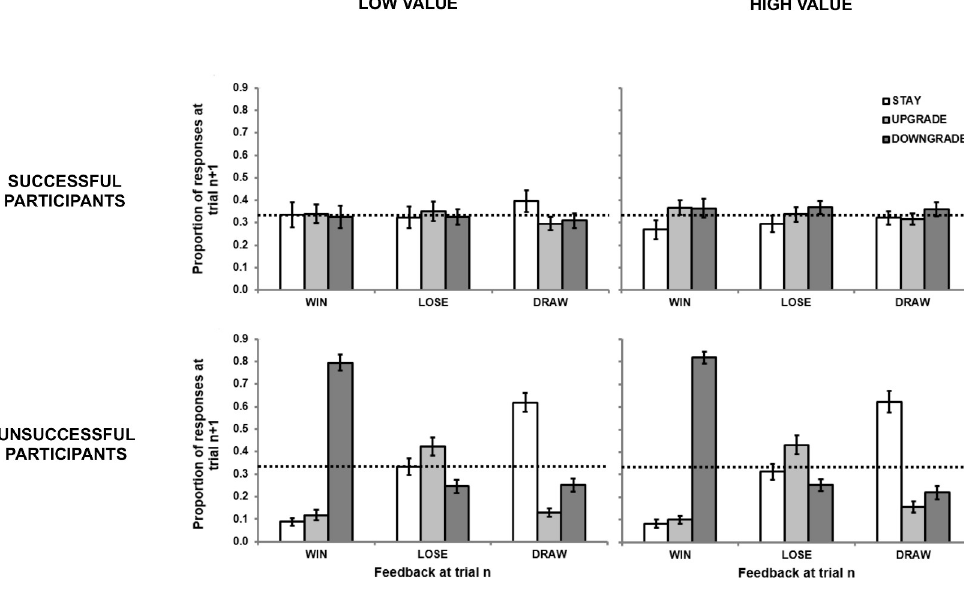
Fig 2. Proportion response data from unsuccessful and successful participants in the exploitable condition of Experiment 1 in terms of the relationship between outcome at trial n ( win , lose , draw ) and the strategy selected at trial n+1 ( stay , downgrade , upgrade ). Error bars represent standard